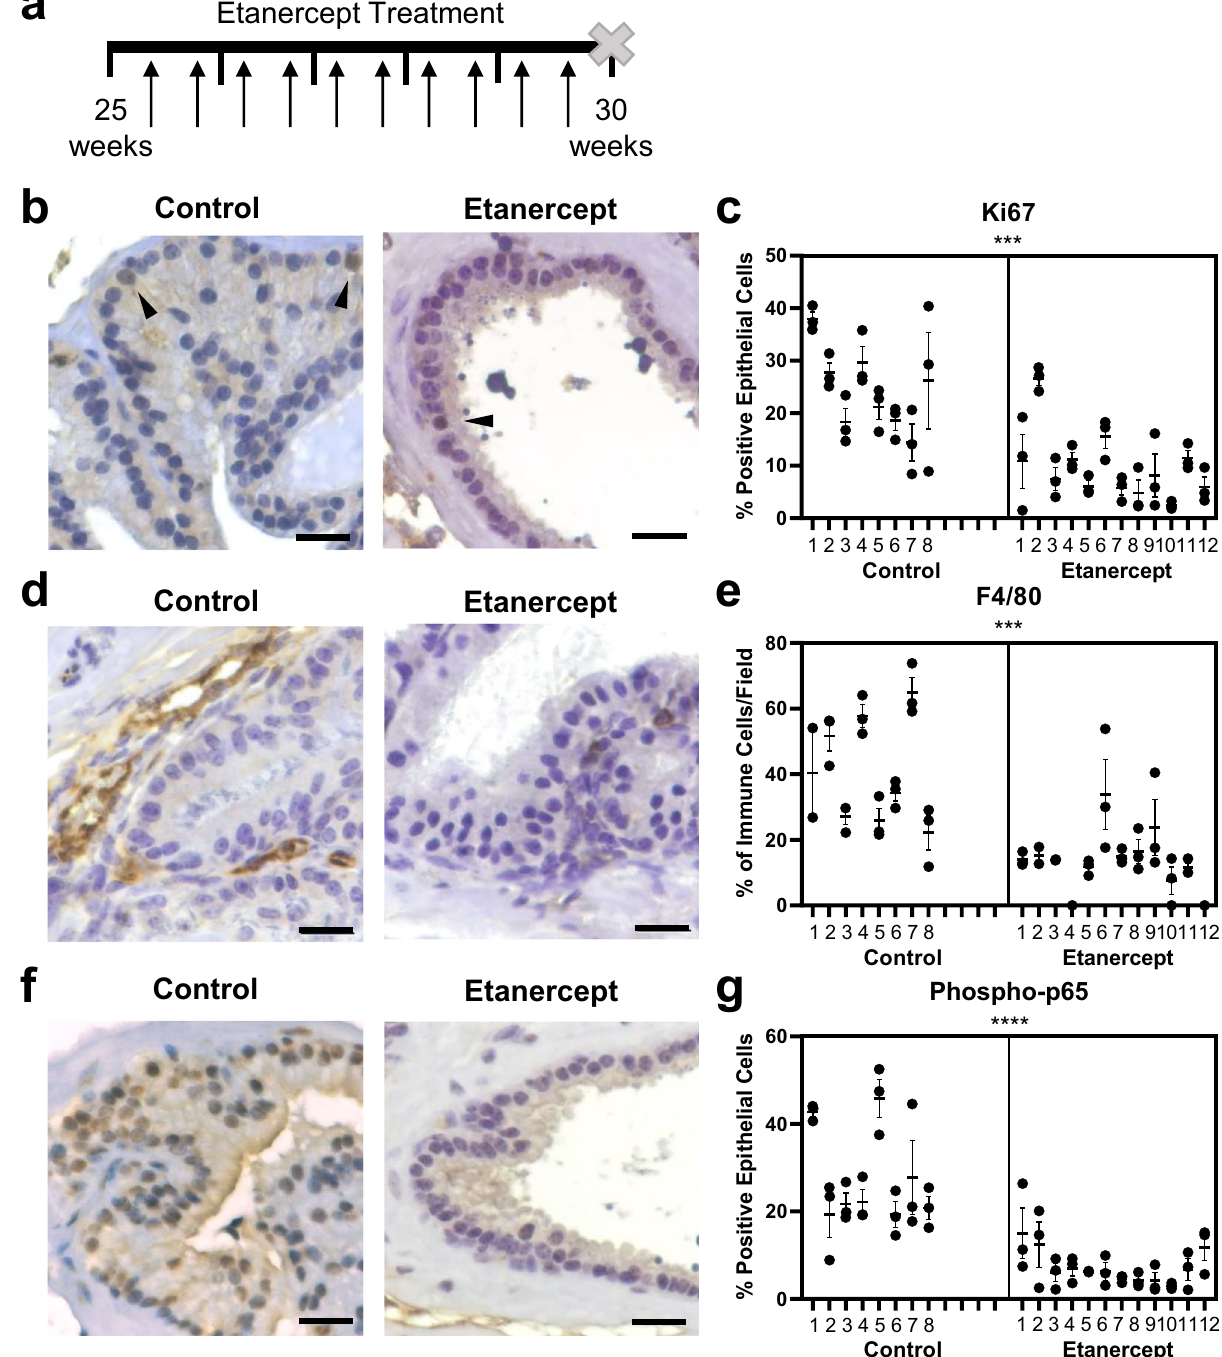
Fig. 4 TNF-antagonist treatment reduces prostatic epithelial proliferation, macrophage in fi ltration, and NF κ B activity in NOD mice. a Diagram representing the timeline of treatment in NOD mice. Mice were treated twice per week for 5 weeks with 4 mg/kg etanercept or PBS vehicle, indicated with black arrows. At the end of the 5-week treatment period, tissues were harvested for analysis. b Representative images of Ki67 staining in control or etanercept-treated mice, where brown color indicates positive staining. c Graph indicating the quantitative summary of Ki67 IHC as the percent of positive epithelial cells per fi eld (*** p = 0.0002). d Representative images of F4/80 + staining in control or etanercept-treated mice, where brown color indicates positive staining. e Quantitative summary of IHC staining for F4/80 + cells, represented as the portion of all immune cells in each fi eld (*** p = 0.0002). f Representative images of phospho-p65 staining in control or etanercept-treated mice, where brown color indicates positive staining. g Data presented indicate the percentage of phospho-p65 positive epithelial cells counted per fi eld of view (**** p < 0.0001). c , e , g Data indicate the mean ± SEM of the percent positive cells in the indicated number of prostate tissue fi elds for each animal ( n = 8 for control-treated and n = 12 for etanercept-treated). Comparison of control and etanercept-treated groups for statistical purposes was conducted using a two-tailed nested t test and asterisks indicate the signi fi cance of the treatment. Source data are provided as a Source Data fi le. Scale bars = 20 µ m.